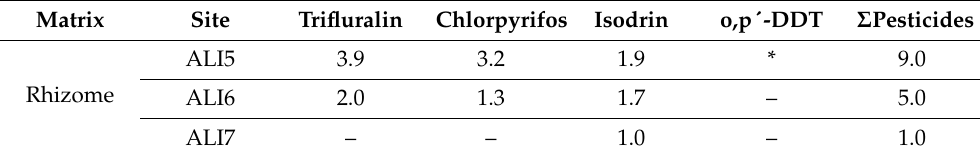
Table 3. Occurrence of the priority pesticides ( µ g kg − 1 d.w.) in the rhizomes of P. oceanica . Note that only the sampling areas where contamination was detected have been included in the table.